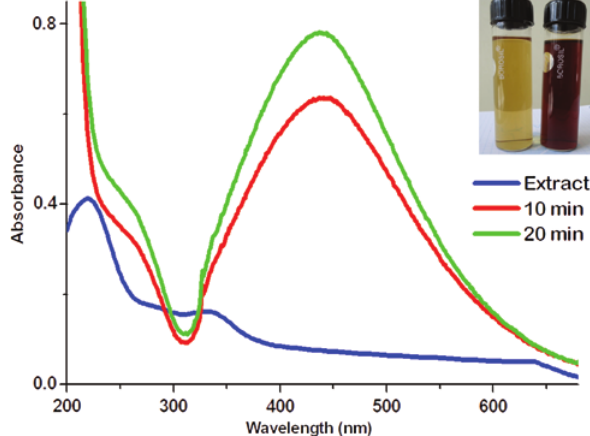
Figure 1: UV-vis spectra of M. polymorpha leaf extract and synthe- sized AgNPs. Experimental conditions: 85 ml of 5 mm AgNO tion + 15 ml of the M. polymorpha extract. Inset shows the change in color after 30 min and the formation of